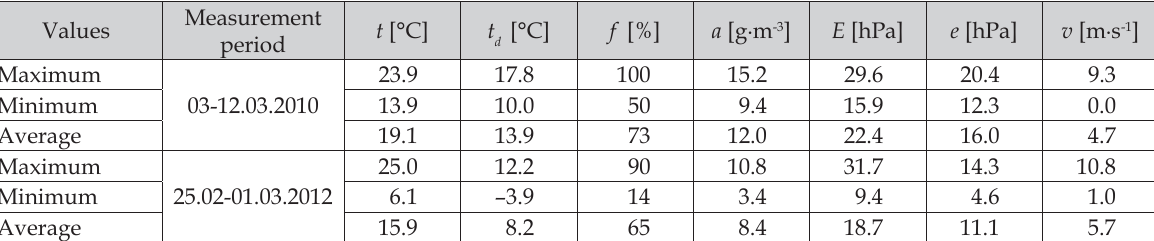
Table 1. Maximum, minimum and average values of the selected meteorological elements ( t – air temperature,